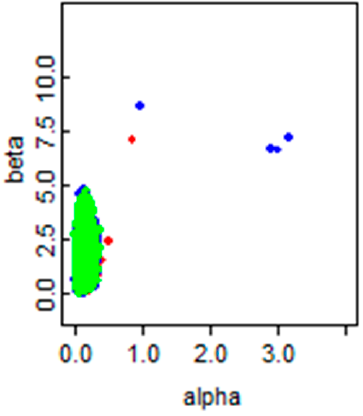
Figure 7. The correlation of (cid:2009) and (cid:2010).